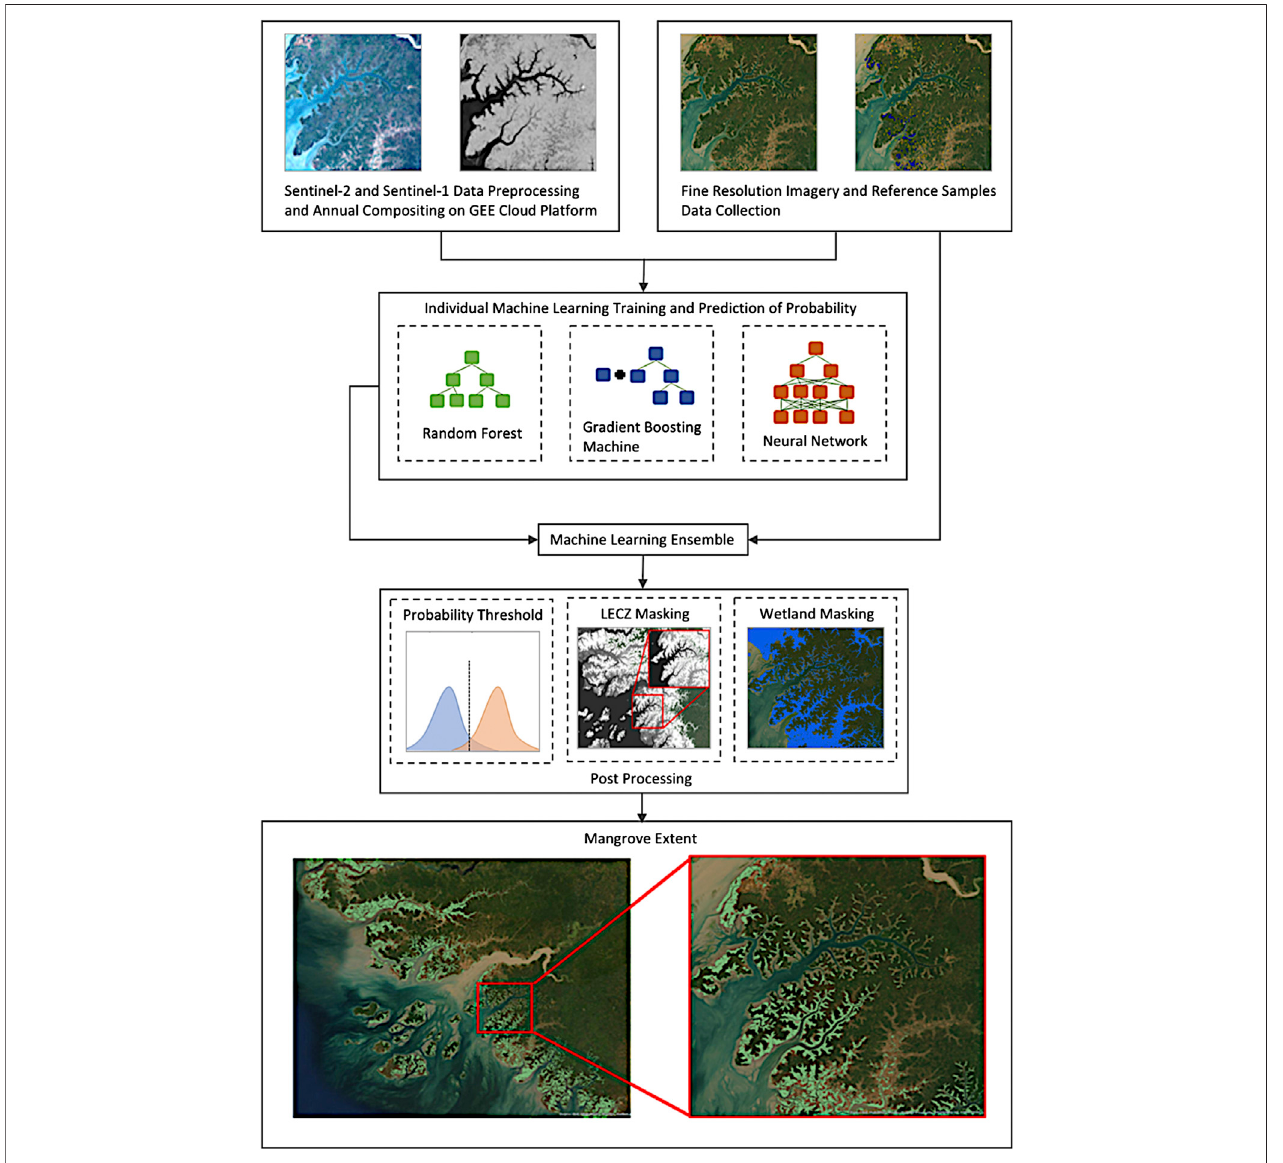
FIGURE 2 | Illustration of the overall work fl ow for mangrove extent data production using the machine learning ensemble of RF, GBM, and NN. All the procedures are automatic except the wetland masking in the post processing step for which we interactively removed some minor pixel clusters through overlaying with existing wetland maps and comparing with fi ne resolution images, as we assume mangrove pixels must be located within wetland areas.